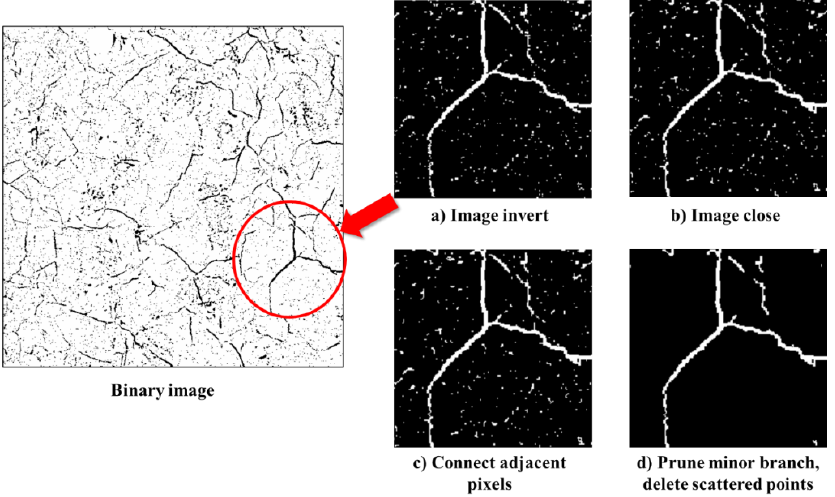
Figure 5. Adjustment of MMSF image, prior to crack extraction. Steps include ( a ) image convert; ( b ) image close; ( c ) scattered pixels connection; and ( d ) prune cut.